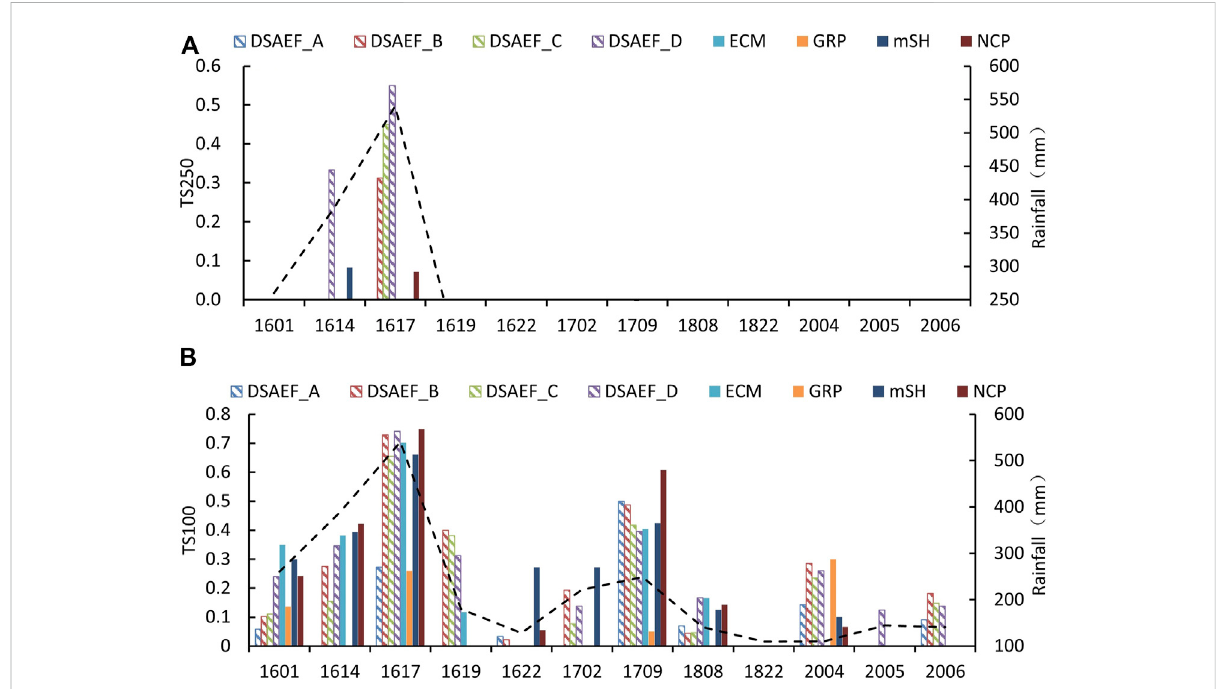
FIGURE 6 Comparison of the TS (histogram) in the four DSAEF_LTP model experiments and four NWP models (ECM, GRP, NCP, mSH) for each TC in independent forecast experiments and the maximum single-station accumulated precipitation (dashed line) for each TC accumulated precipitation (A) above 250 mm and (B) above 100 mm.